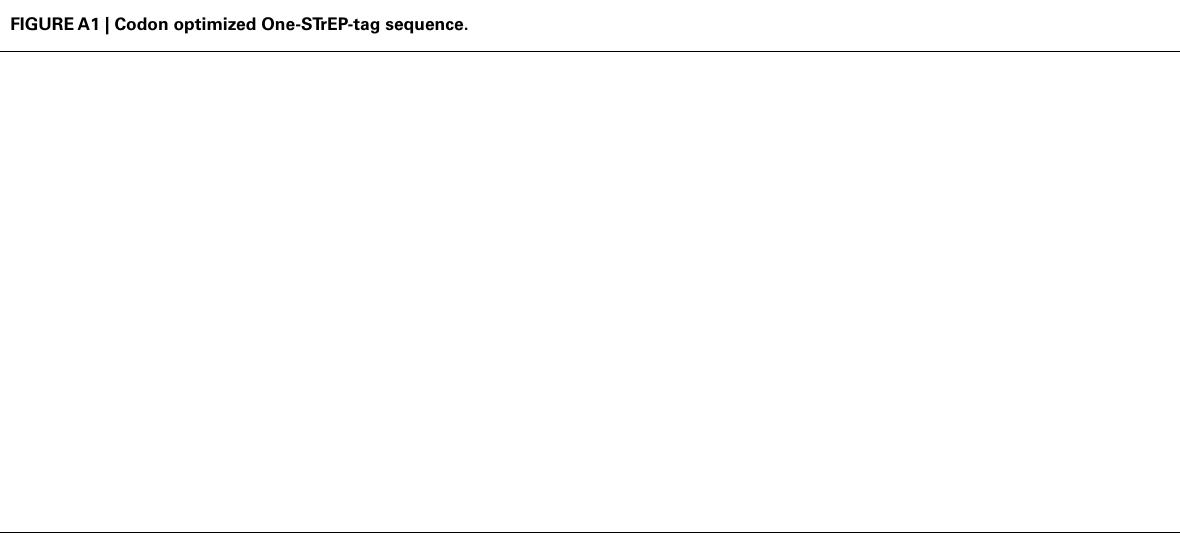
FIGUREA1 | Codon optimized One-STrEP-tag